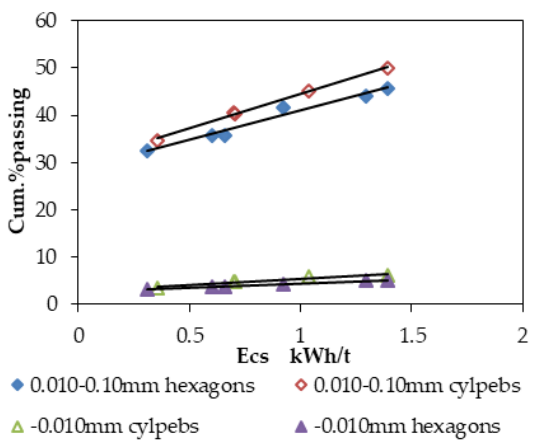
Figure 13. The mass percentage of 0.01–0.10 mm ground product and particles greater than 0.01 mm in relation to specific energy.